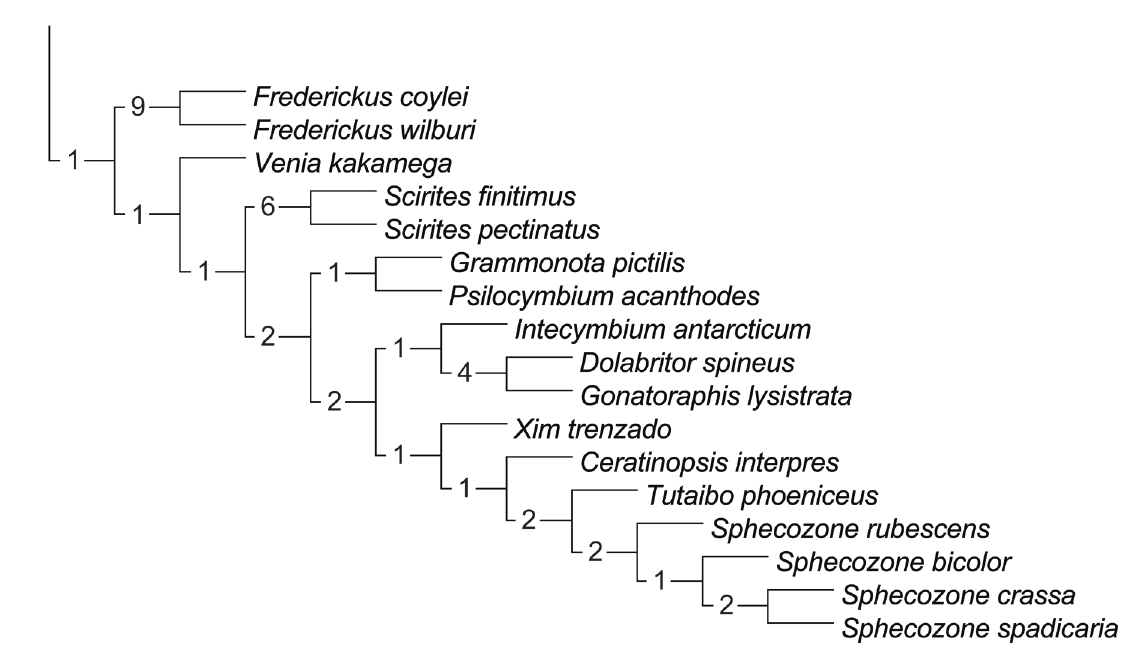
Fig. 6. Strict consensus tree of the eight most parsimonious trees, showing only the distal clades where Xim trenzado gen. et sp. nov. is situated. Tree with Bremer support values noted beside